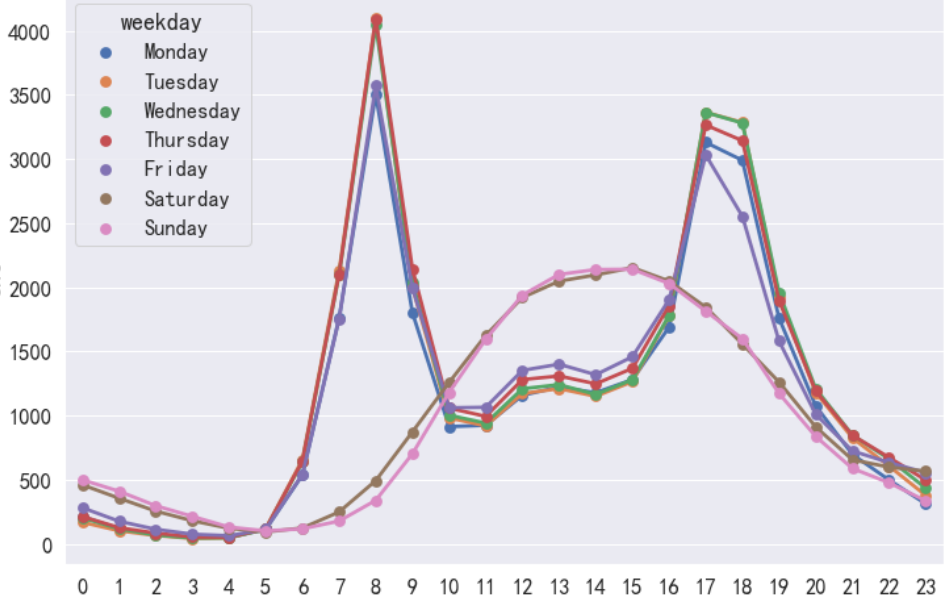
Figure 7. Shared bike usage per hour of